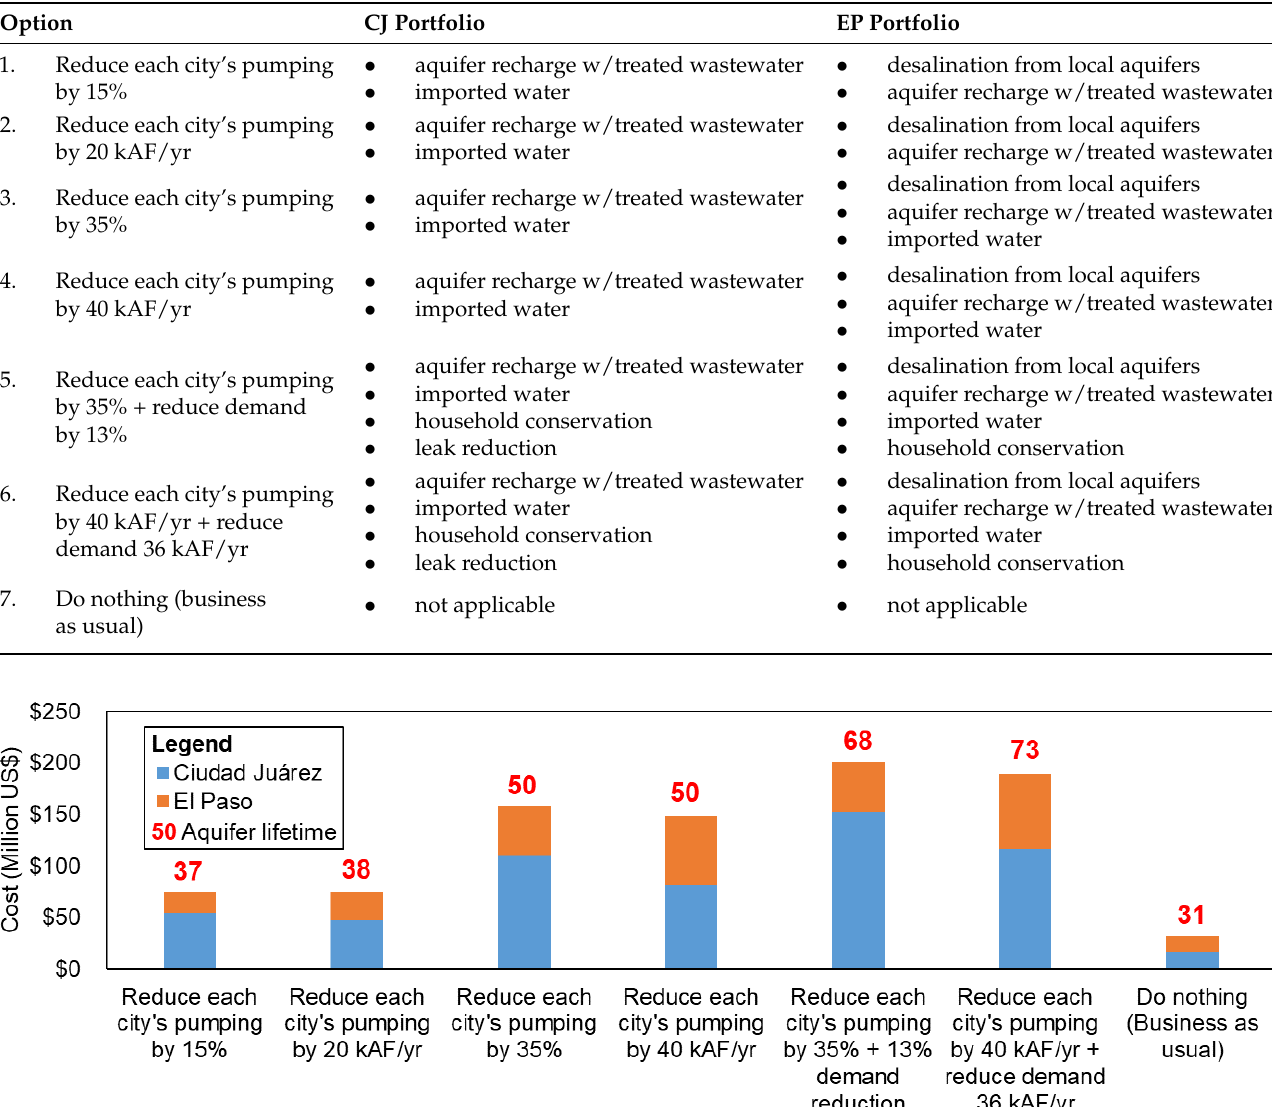
Table 5. Primary water supply gain or demand reduction alternatives for each option and city.